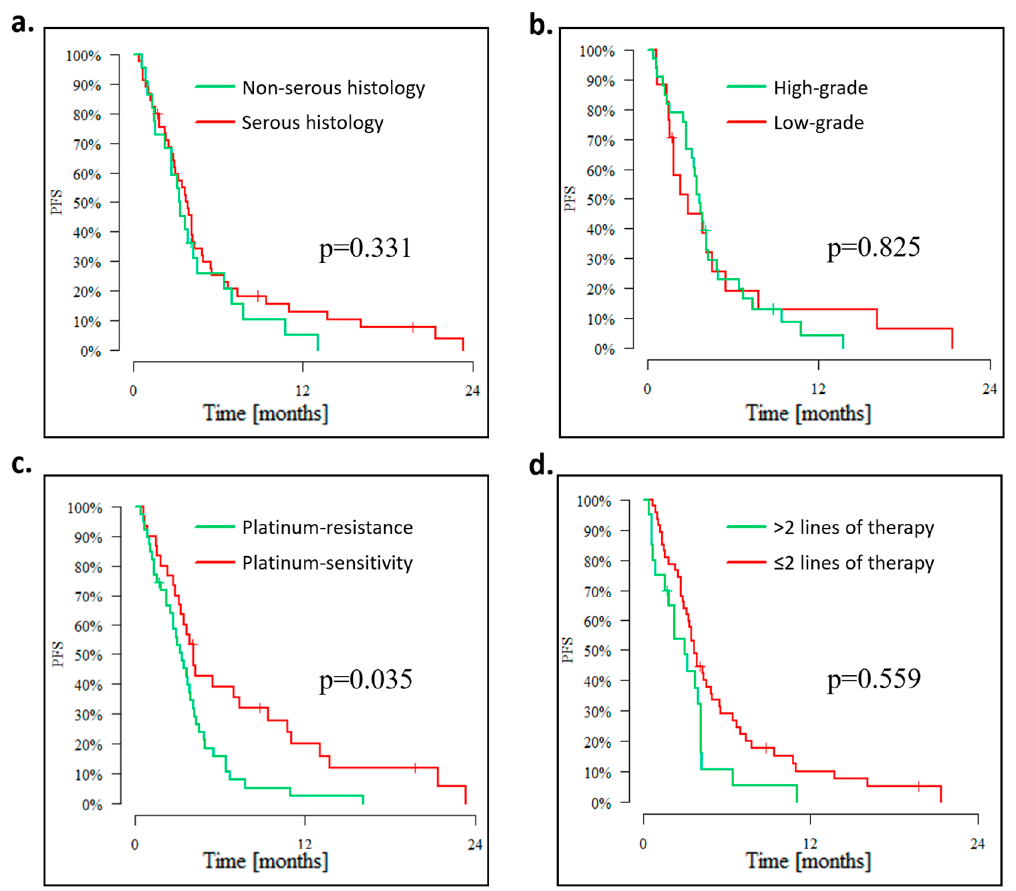
Figure 3. Progression-free survival ( a ) according to histology; ( b ) according to tumor grade; ( c ) ac- cording to platinum-sensitivity, ( d ) according to the number of lines of previous systemic treatment. The number of previous lines of systemic treatment and platinum sensitivity